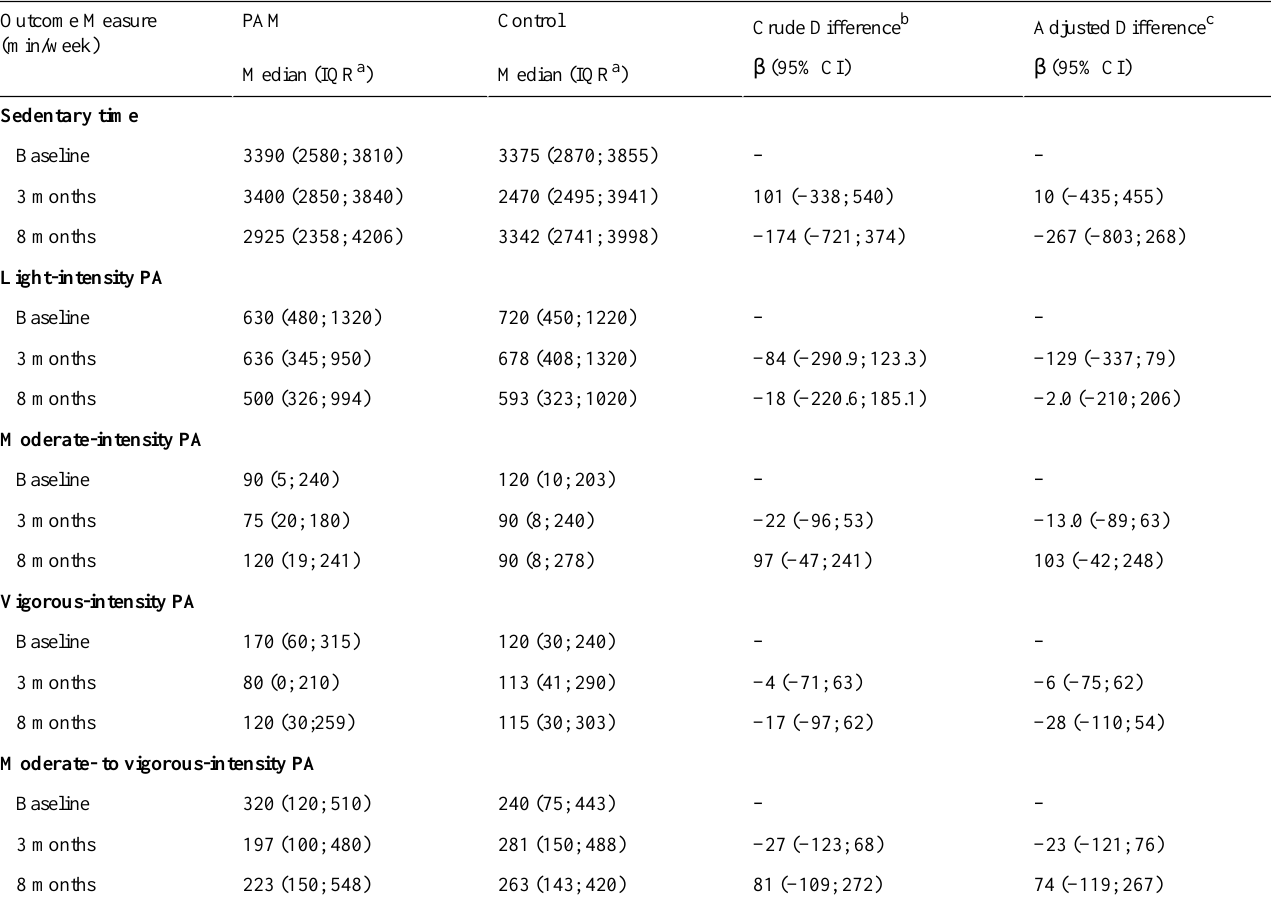
Table 3. Median PA scores and mean difference in PA and sedentary time between PAM intervention group and control group at baseline (n=51 in each group), 3 months (control: n=49; intervention n=46), and 8 months (control: n=42; intervention n=38)